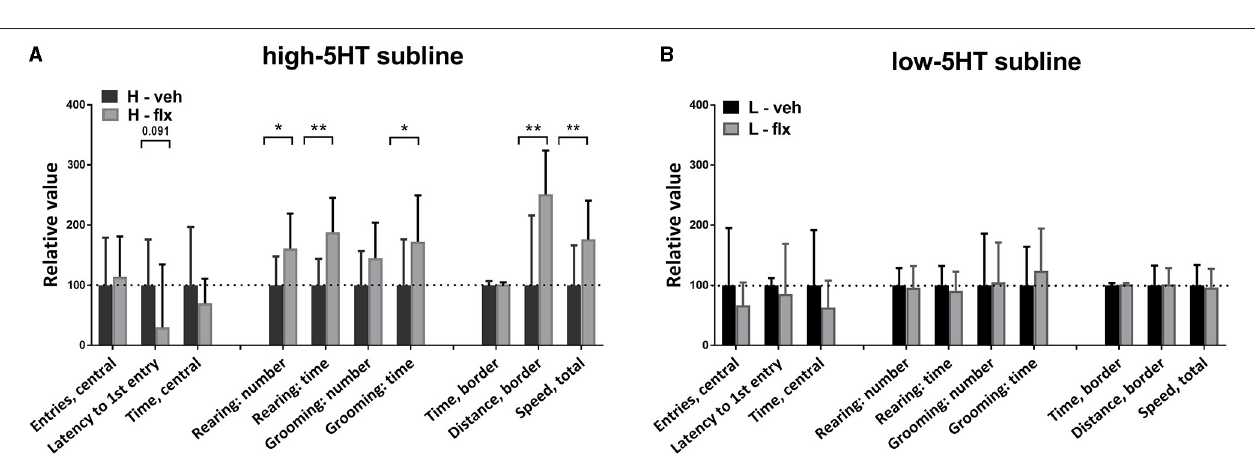
FIGURE 4 | Effect of 16-day fluoxetine treatment on the behavior of (A) high-5HT and (B) low-5HT animals in the open field test. Measured behavioral categories are indicated in the X-axis legend. All values are relative to the mean/median values of the respective vehicle group (set to 100%, dotted line). Data are presented as means and SD or medians and upper quartile (Q3), n = 8 (vehicle-treated) or 16–17 (fluoxetine-treated). p -values obtained by LSD or Dunn’s post-hoc test after 1w-ANOVA or KW test, respectively, are indicated. Full statistical data, together with absolute values of all measured parameters, are given in Supplementary Table 2 . H, high-5HT animals; L, low-5HT animals; veh, vehicle; flx, fluoxetine. * p < 0.05 and ** p <